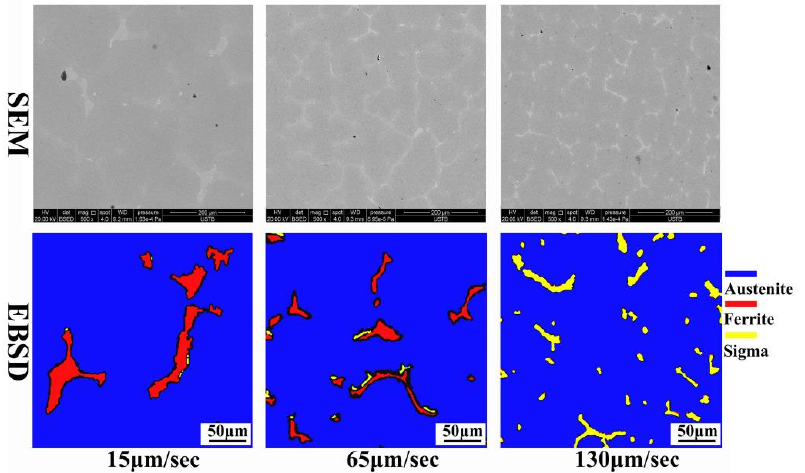
Figure 7. EBSD phase distribution images for Ce ‐ HMASS steel under different pulling rate. From the EBSD phase distribution diagram, the second phase proportion of the solidified structure was determined to change with the pulling rate, as shown in Figure 8. The proportion of the ferrite phase in the solidification structure is negatively correlated with the pulling rate. As the pulling rate increases from 15 μ m/sec to 130 μ m/sec, the proportion of ferrite phase decreases from 6.6% to 0.